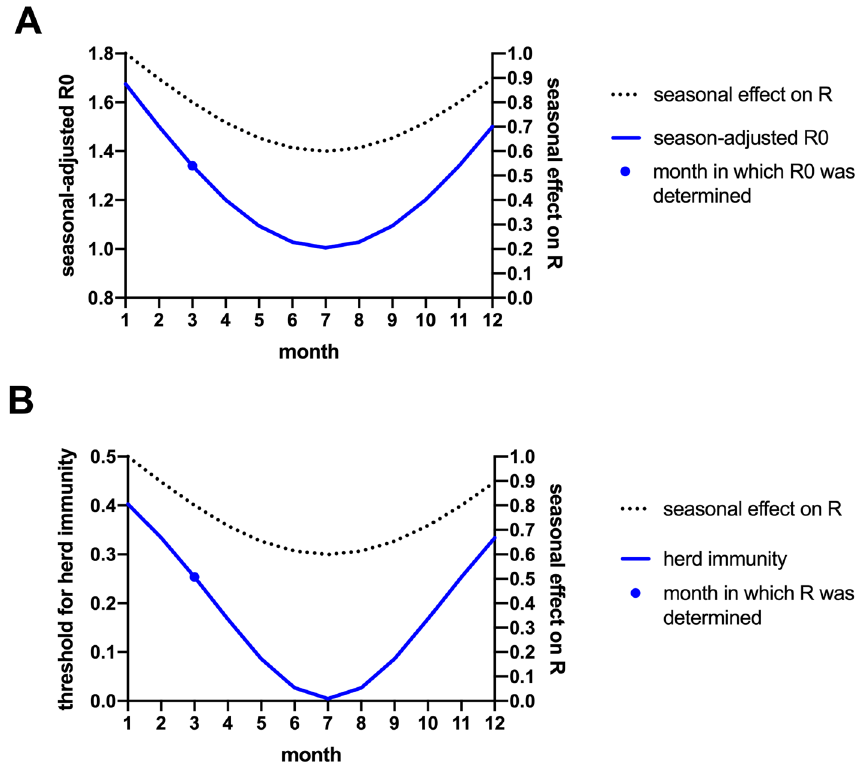
Figure 5. Seasonal influence on R0 and herd immunity. ( A ) The seasonal effect on R0 can be assumed as a sine function with a maximum in January and a 40% lower minimum in July (dashed line, right y-axis). This translates into an oscillating R0 with a maximum in January (of R0 January = 1.68) and a minimum in July (R0 July = 1.01) (blue line, left y-axis). R0 calculations are based on the values calculated for March (R0 March = 1.34) (blue dot) ( B ) Herd immunity similarly to R0 oscillates in a seasonal